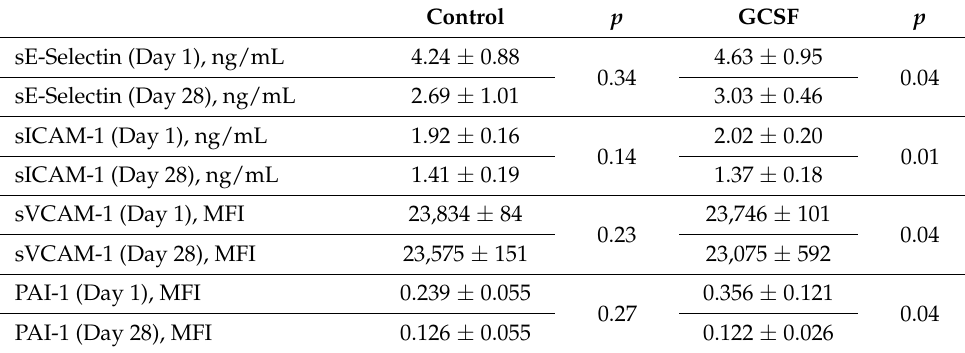
Data are expressed as mean ± standard error of the mean. Differences between days 1 and 28 were assessed with the Wilcoxon signed-rank test. GCSF: granulocyte colony-stimulating factor, ICAM-1: intercellular adhesion molecule-1, VCAM-1: vascular cell adhesion molecule-1.